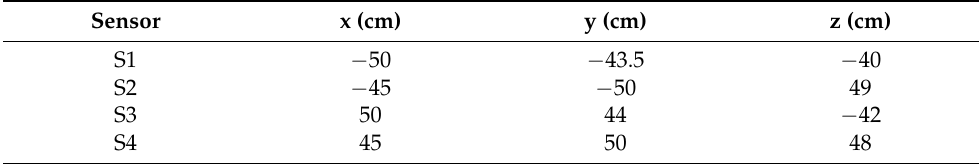
Figure 3. Coordinate system diagram illustrating the TEV sensors (outside the tank) and PD source locations (inside) simulated MV switchgear panel. Table 1. TEV sensor